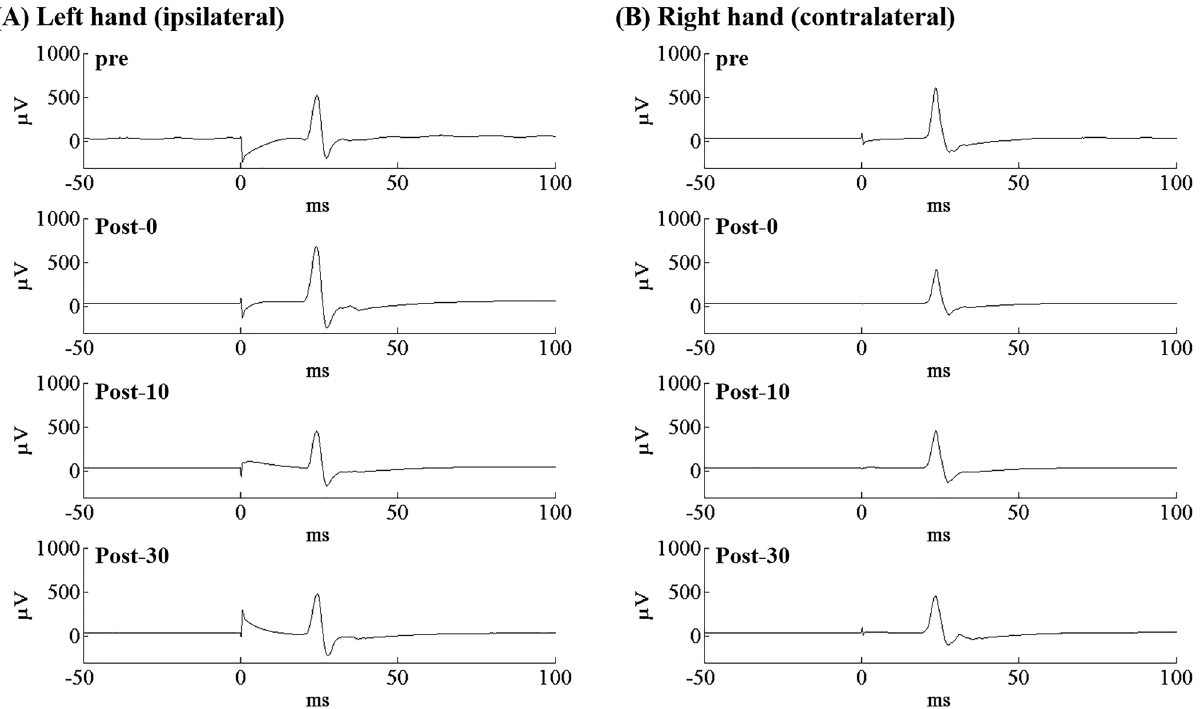
Figure 2. MEPs changes by the real stimulation in a representative subject. This figure shows MEPs changes in the left ( A ) and right ( B ) hand from a representative subject after the real stimulation. MEPs amplitude increases in the left hand immediately after the stimulation ( A ). On the other hand, it reduces in the right hand for at least 30 min after the stimulation ( B Table 2 shows the summary of mean ± SEM of rMT for the right hand, SI1mV for the left hand and MEPs peak-to-peak amplitudes in Real and Sham stimulation. There were no significant differences between Condition